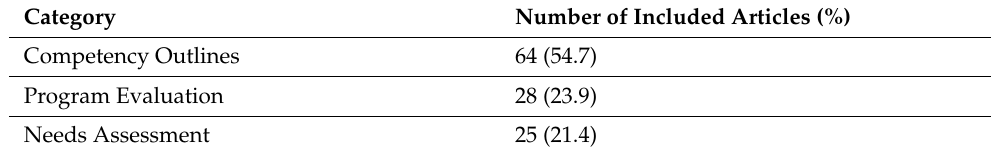
Table 1. Scoping Review